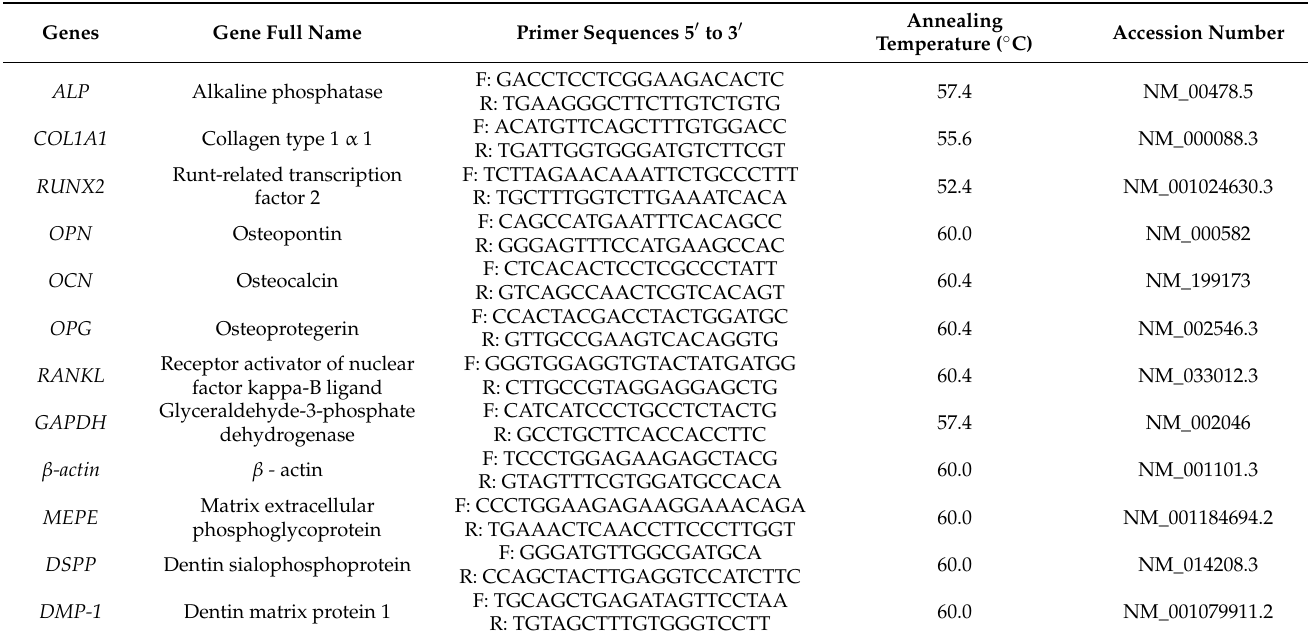
Table 1. Primer sequences and annealing temperatures of individual genes used in